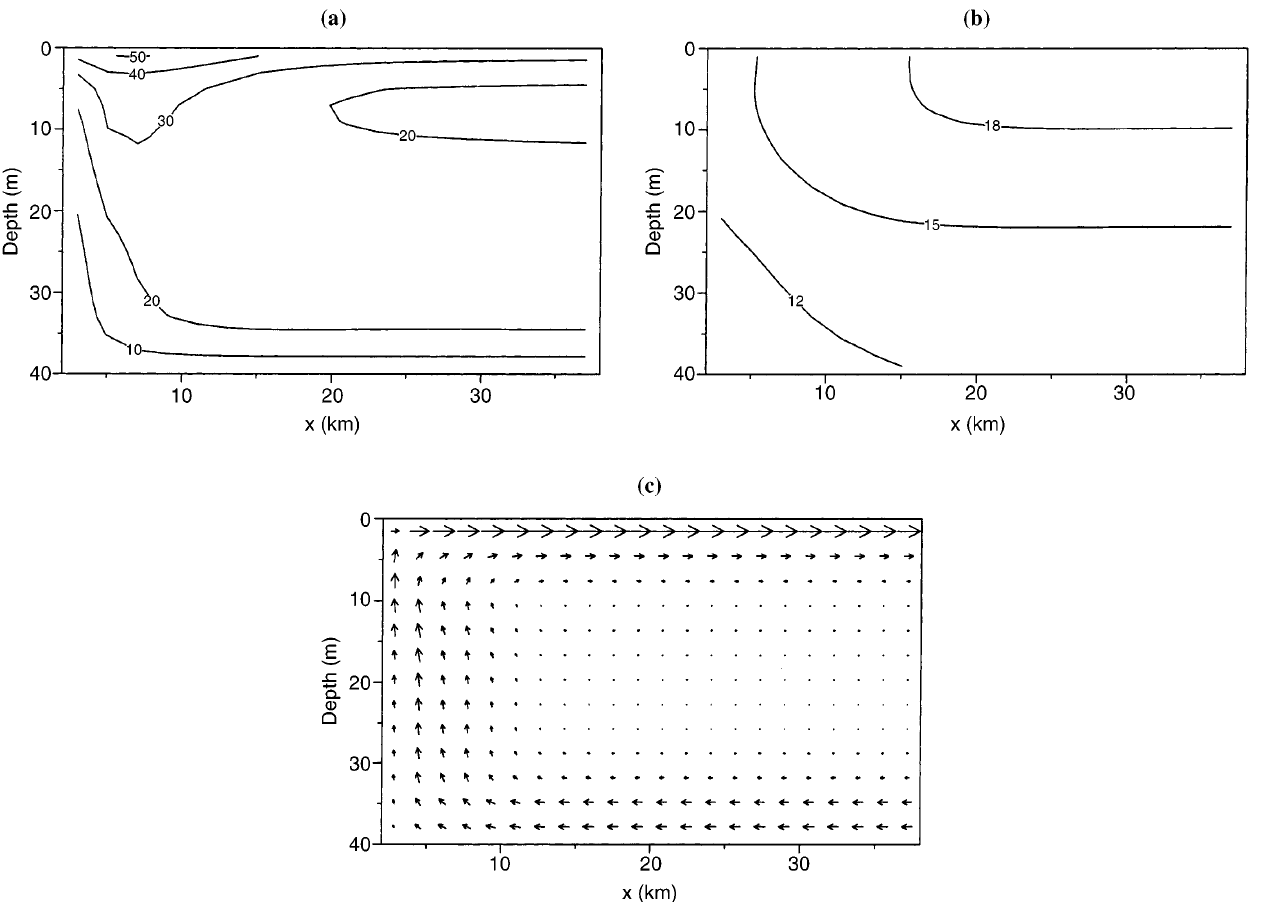
Fig. 9a–c. Solution of the initial simulation of a coastal upwelling with a constant turbulent viscosity (cid:133) m t (cid:136) 10cm 2 (cid:1) s (cid:255) 1 (cid:134) at t (cid:136) 48h : x (km) is the distance to the coast. a velocity v (cid:133) cm (cid:1) s (cid:255) 1 (cid:134) , b temperature ( (cid:14) C), c vertical current vector ~ U (cid:136) (cid:133) u ; w (cid:2) 10 3 (cid:134) , the maximum length is 17cms (cid:255)